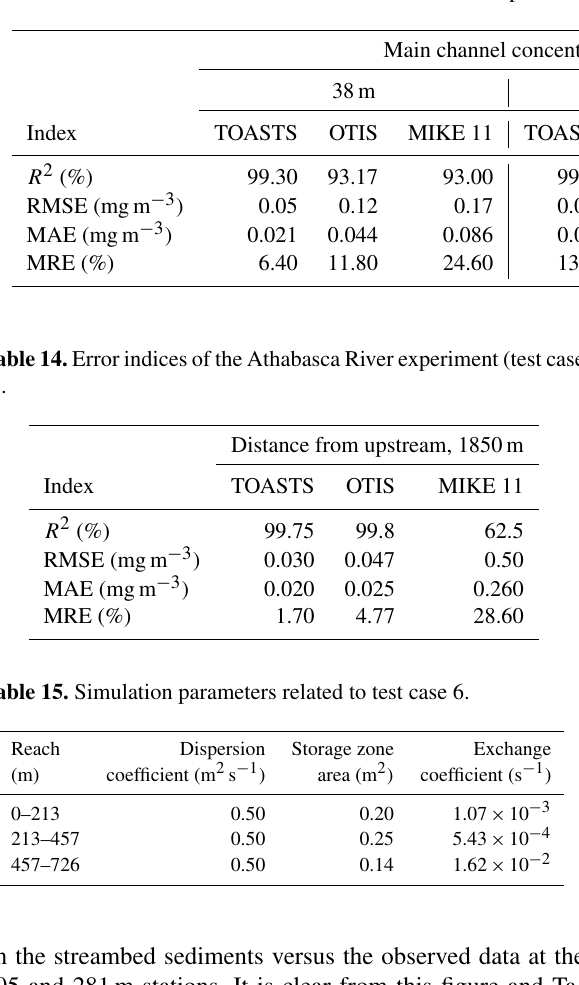
Table 13. Error indices of simulation of the Uvas Creek experiment (test case 4).